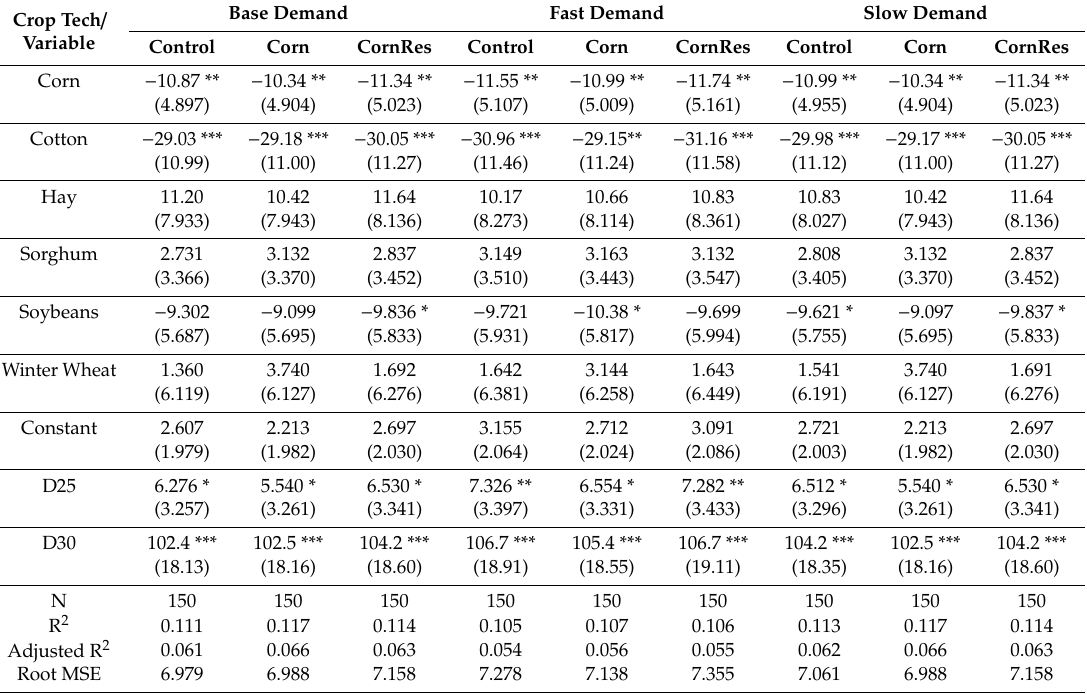
Table 8. Livestock pasture land regression results.